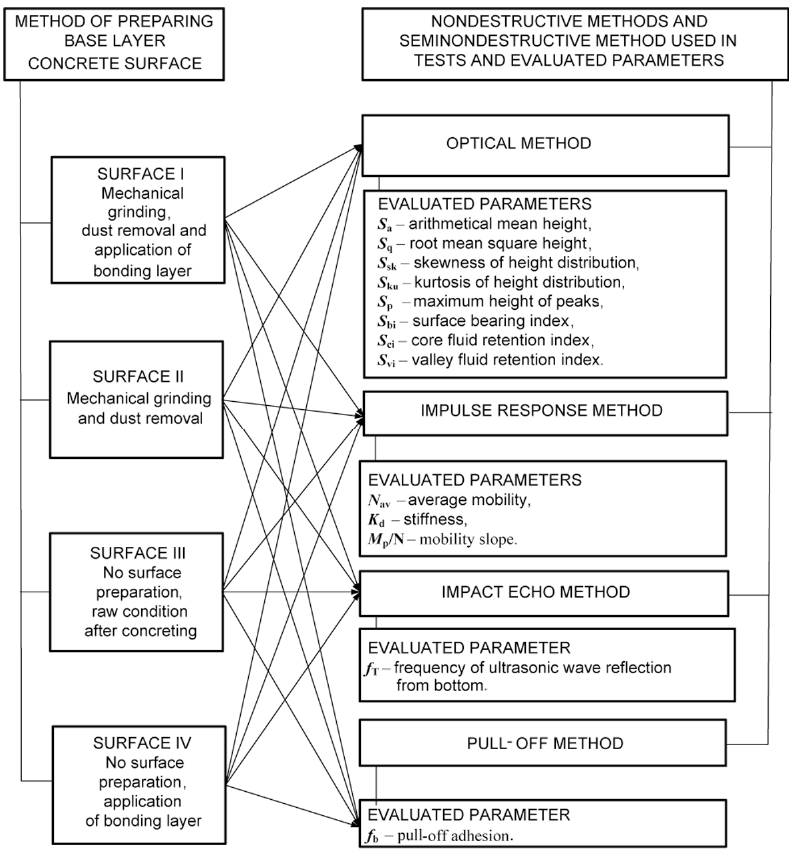
Fig. 2. Scheme of ways of preparing base layer surface in conjunction with investigative nondestructive techniques and seminondest- ructive technique and parameters evaluated by them (Sadowski, Hoła